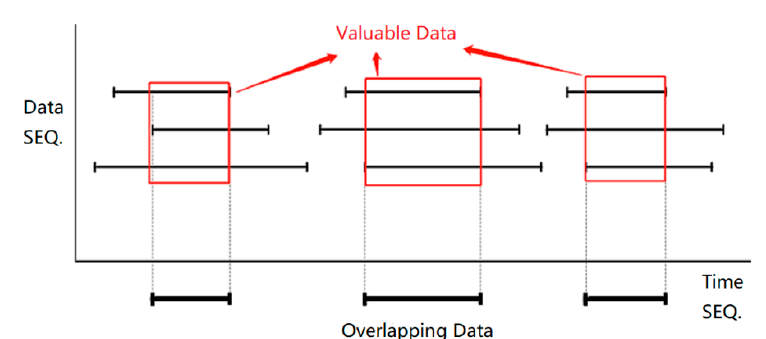
Figure 2. Data trimming diagram.